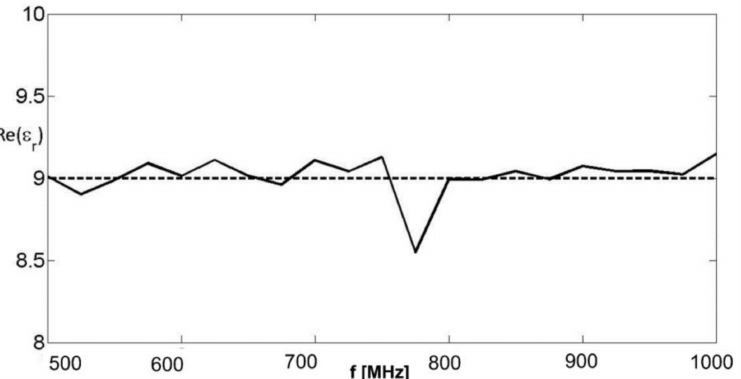
Figure 5. Real part of the equivalent complex permittivity. Solid line: retrieved value; dashed line: actual value. Noisy data with SNR = 10 dB.